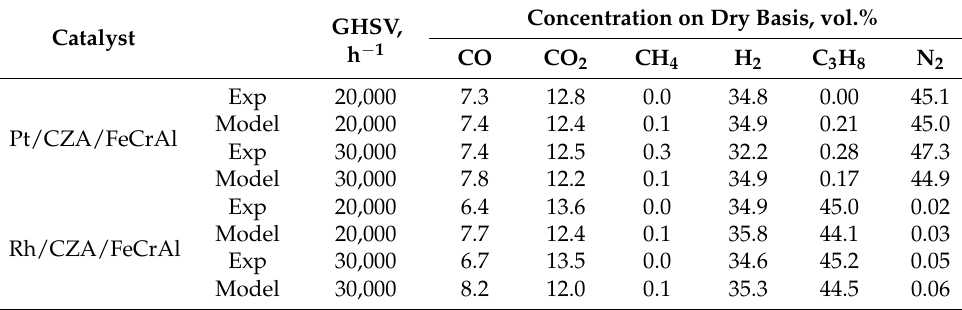
Table 3. Comparison of the modelling results and experiments for the propane OSR.